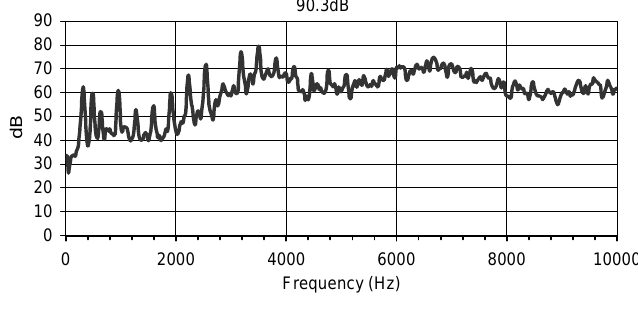
Fig. 11. Spectrum of the measured noise shown in Fig.